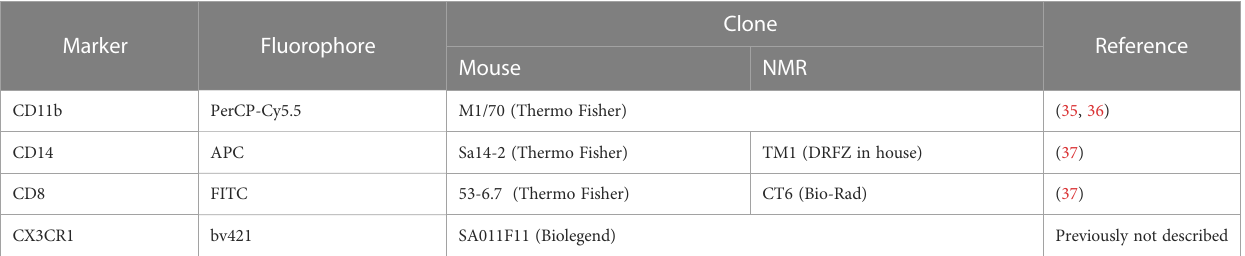
TABLE 2 Fluorophore-conjugated antibodies to mouse and NMR immune cell markers used in the cytometric assay. Marker